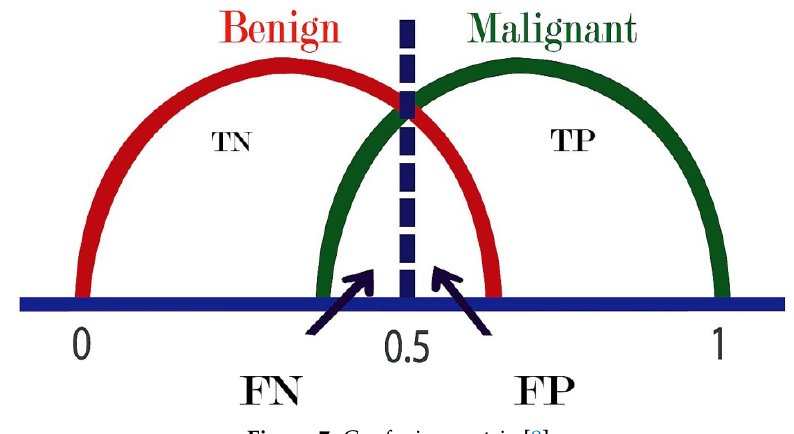
Figure 7. Confusion matrix [8].